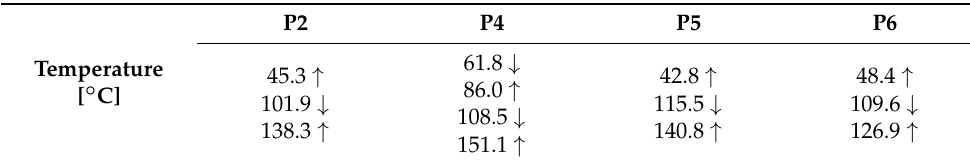
Table 2. DSC peaks ( ◦ C) of P2, P4–P6 peptides obtained.